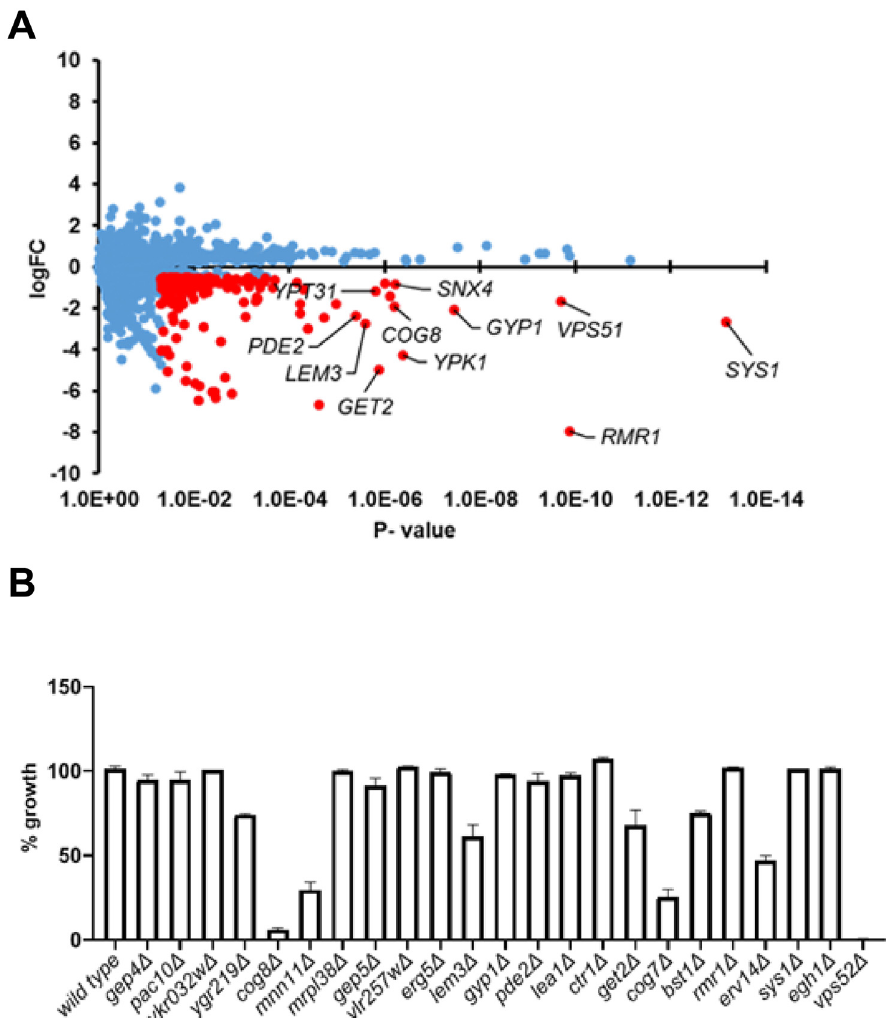
Fig 3. Homozygous profiling of auroramycin in Saccharomyces cerevisiae . (A)log FC (Fitness Coefficient) was plotted against P-value for the 4817 mutants that were analysed by HOP. Mutants with higher sensitivity to auroramycin have more negative log FC values. Individual mutants are indicated as blue circles. Mutants sensitive to auroramycin (log FC < -0.5 and P-value < 0.05) are indicated as red circles. For the sake of clarity, gene names of only a few of the top hits are shown in the plot. (B)Wild type BY4743 and 23 deletion strains that were sensitive to auroramycin in chemogenomic profiling assay, were grown in YPD-HEPES in the presence of either DMSO or auroramycin at 1.56 μ M in duplicate. Normalized growth after 16 hours of incubation at 30 ˚C is plotted for each strain. Error bars (n = 2 Mean ± S.D) are indicated in the plots. Representative data from two independent experiments are shown in the